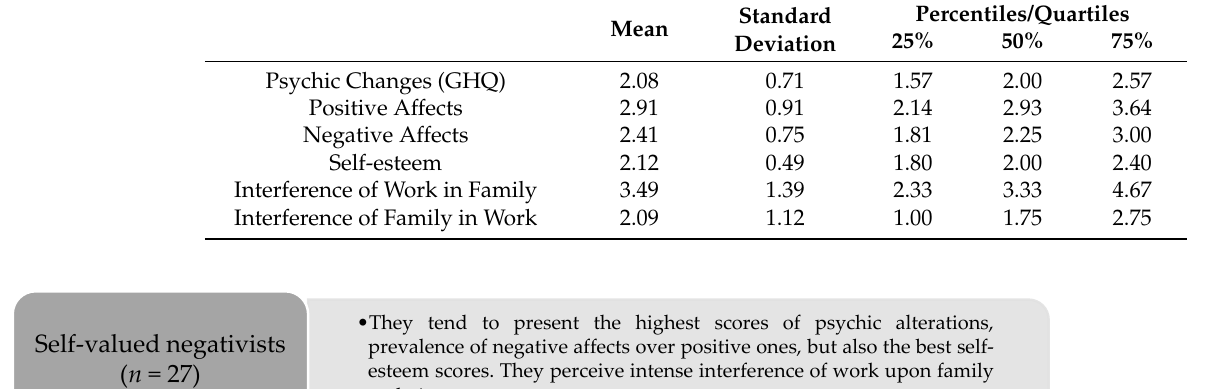
Table 2. Participants’ scores by the indicators of mental health ( n = 285).